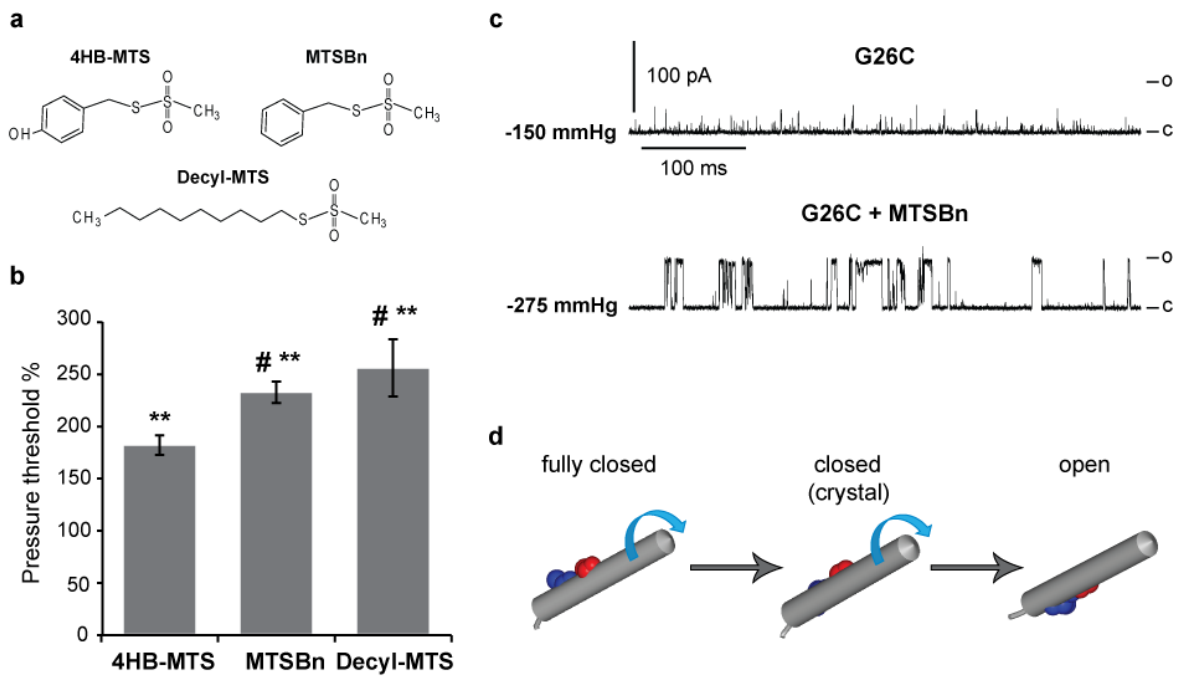
( d ) A graphic depicting TM1 and the modeled positions of residues G22 and G26. TM1 is represented in a fully closed, closed (crystal structure) and open states. The proposed clockwise rotation of TM1 during MscL gating is represented by the blue arrows. ** p ≤ 1.8 × 10 −7 in Student t-test paired control vs . treated, # p ≤ 0.03 in Student t-test unpaired vs .